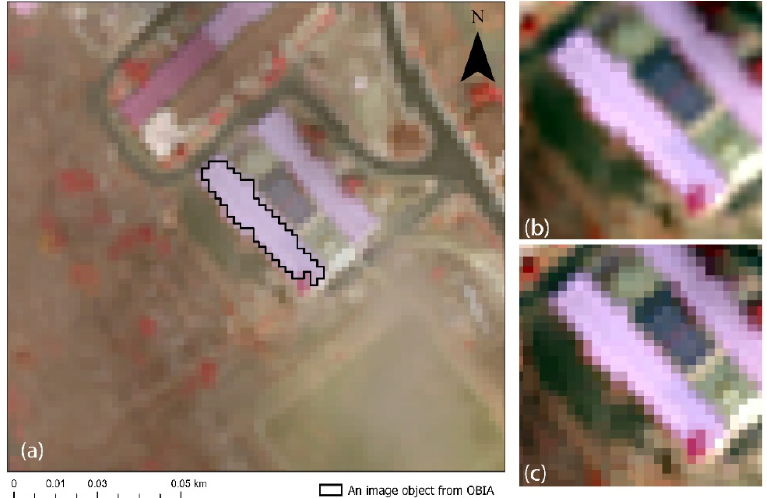
Figure 3. A comparison of chipped image example of an object with/without the Gaussian assistance: ( a ) a selected example of image object from OBIA segmentation, ( b ) the object’s background was blurred using a Gaussian filter, ( c ) the object’s background was not blurred.